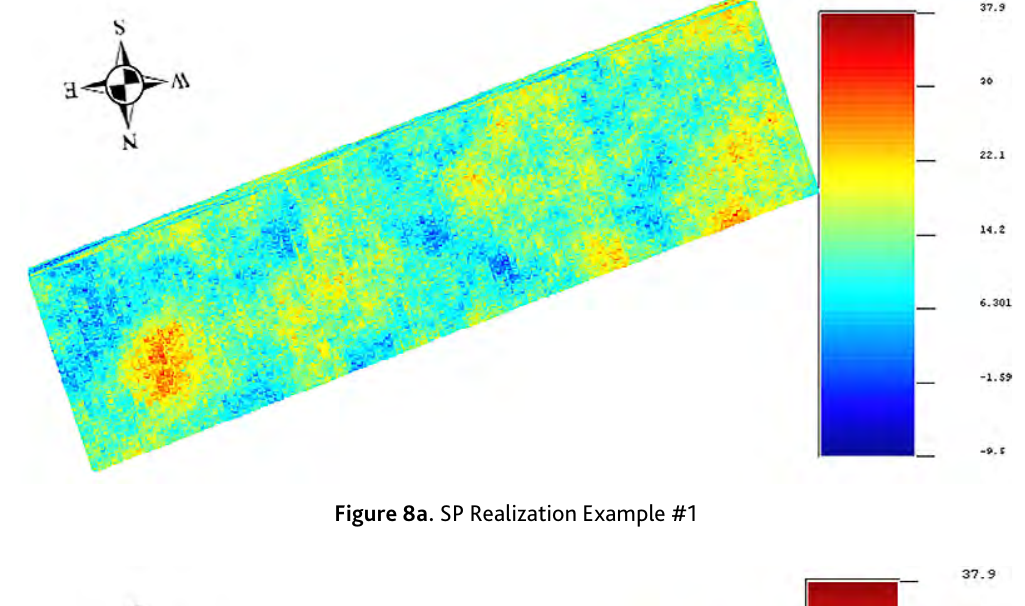
Figure 8a. SP Realization Example #1